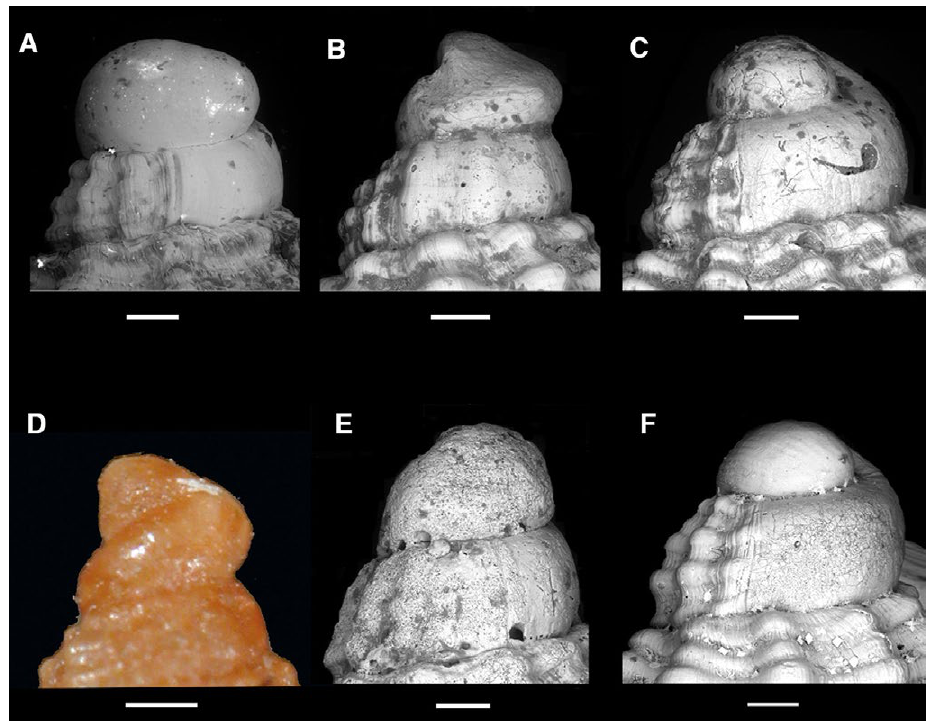
Figs 4. – Protoconch morphology in the Aplus dorbignyi complex. A, Aplus dorbignyi , Djerba, Tunisia (MNHN IM-2013-31697); B, Aplus scaber, Djerba, Tunisia (MNHN IM-2013-31913); C, Aplus sp. , Tarifa, Spain (MNHN IM IM-2009-5219); D, Aplus campisii , southeastern Sicily (holotype, Malacologia Mostra Mondiale, Cupra Marittima: photo courtesy T. Cossignani); E , Aplus assimils , Bizerte, Tunisia (MNHN IM-2013-32513); F, Aplus scacchianus , Elba Is., Italy (MNHN IM-2013-32673). Scale bars 200